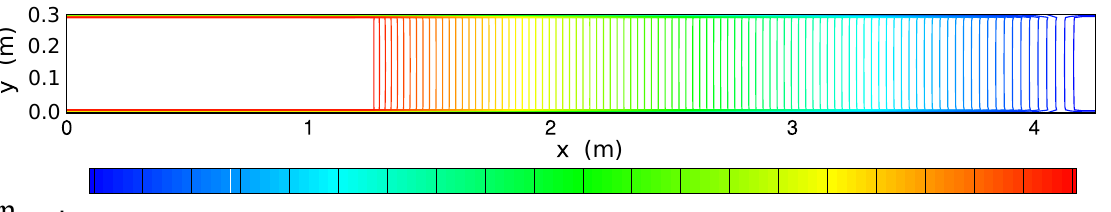
Figure 14. Channel with submerged and emergent vegetation, free surface elevation; where η = ( η − η ) / ( η − η ) . adim min max min